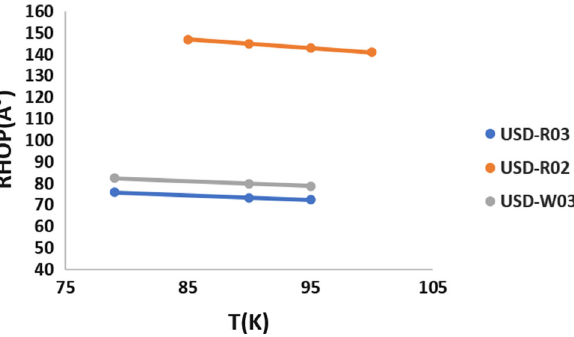
Fig. 8 The variation of hopping length versus temperature for three different detectors